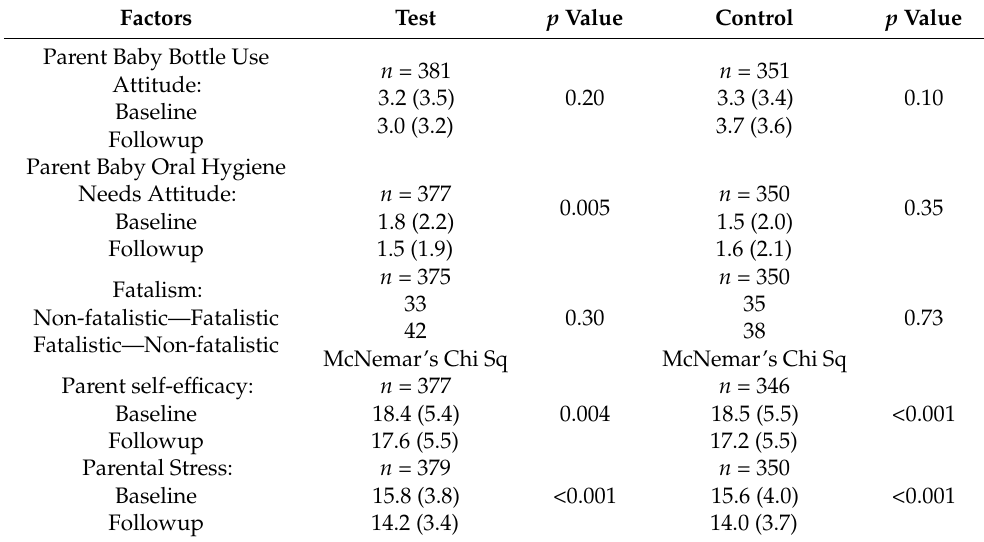
Table 2. Changes in psychosocial factors from baseline to first follow-up for test and control group.